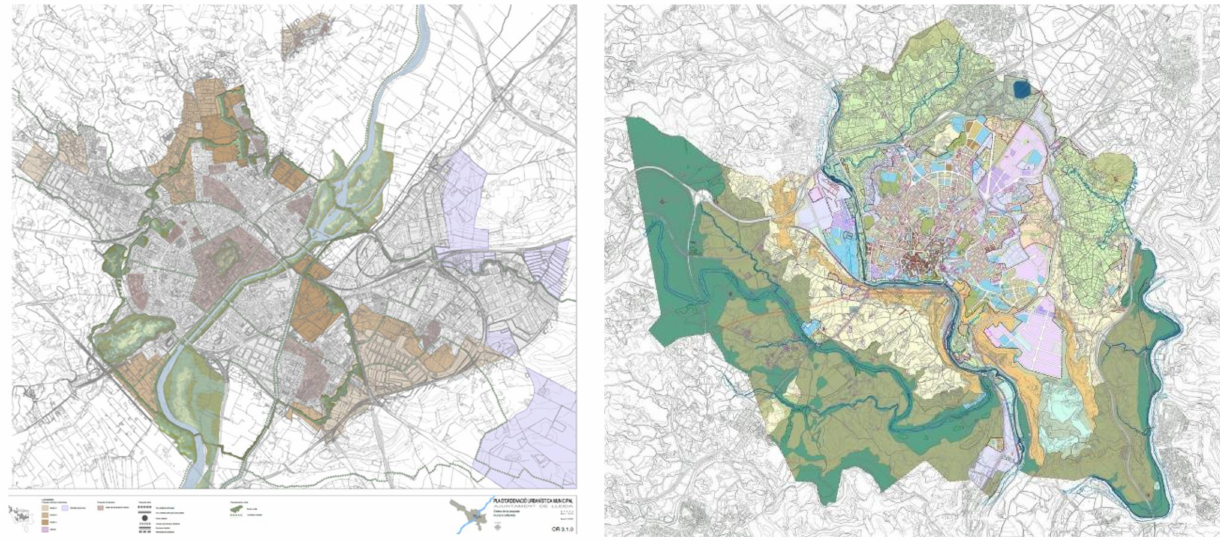
Figure 5. The Plan de Ordenaci ó n Urbana Municipal de Lleida of 2018 ( left ) reprinted with permission from ref. [49] and the Plan de Ordenaci ó n Urbana de Manresa of 2017 ( right ) reprinted with permission from ref.